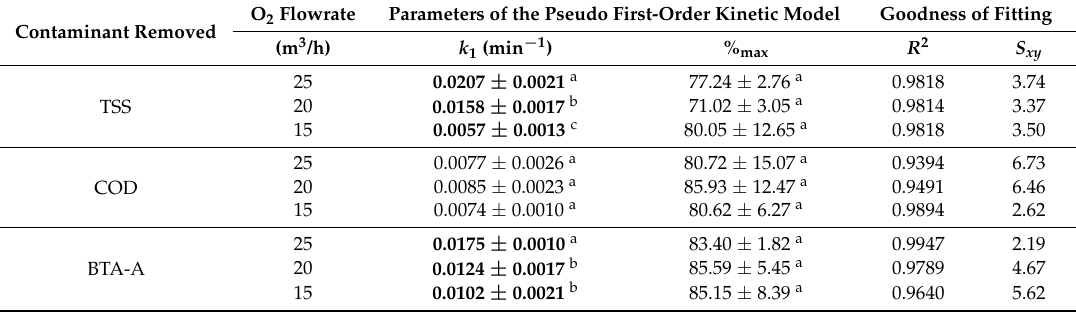
Table 1. Parameters obtained from the fittings of experimental results on the removal of total suspended solids(TSS), chemical oxygen demand (COD) and benzotriazole based anticorrosive (BTA-A) under different O 2 flow rates to the pseudo first-order kinetic